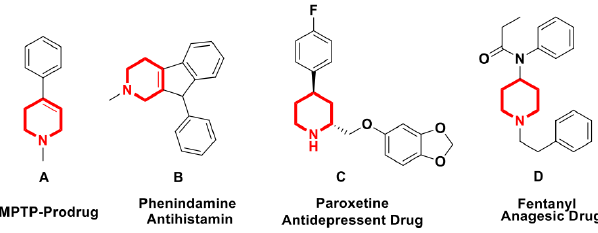
Figure 1. Some biologically active tetrahydropyridine drugs.